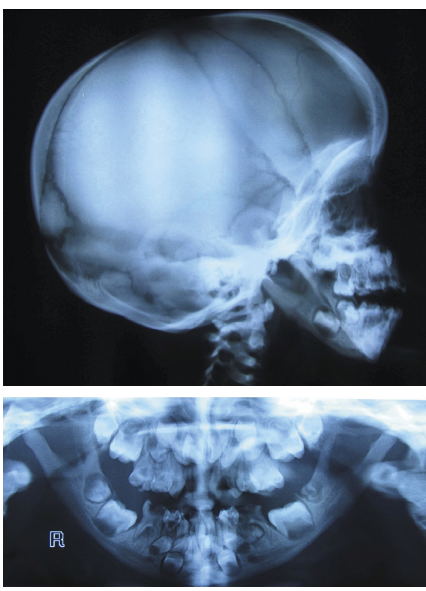
Figure 2: Open fontanels and obtuse mandibular angle in PDO.